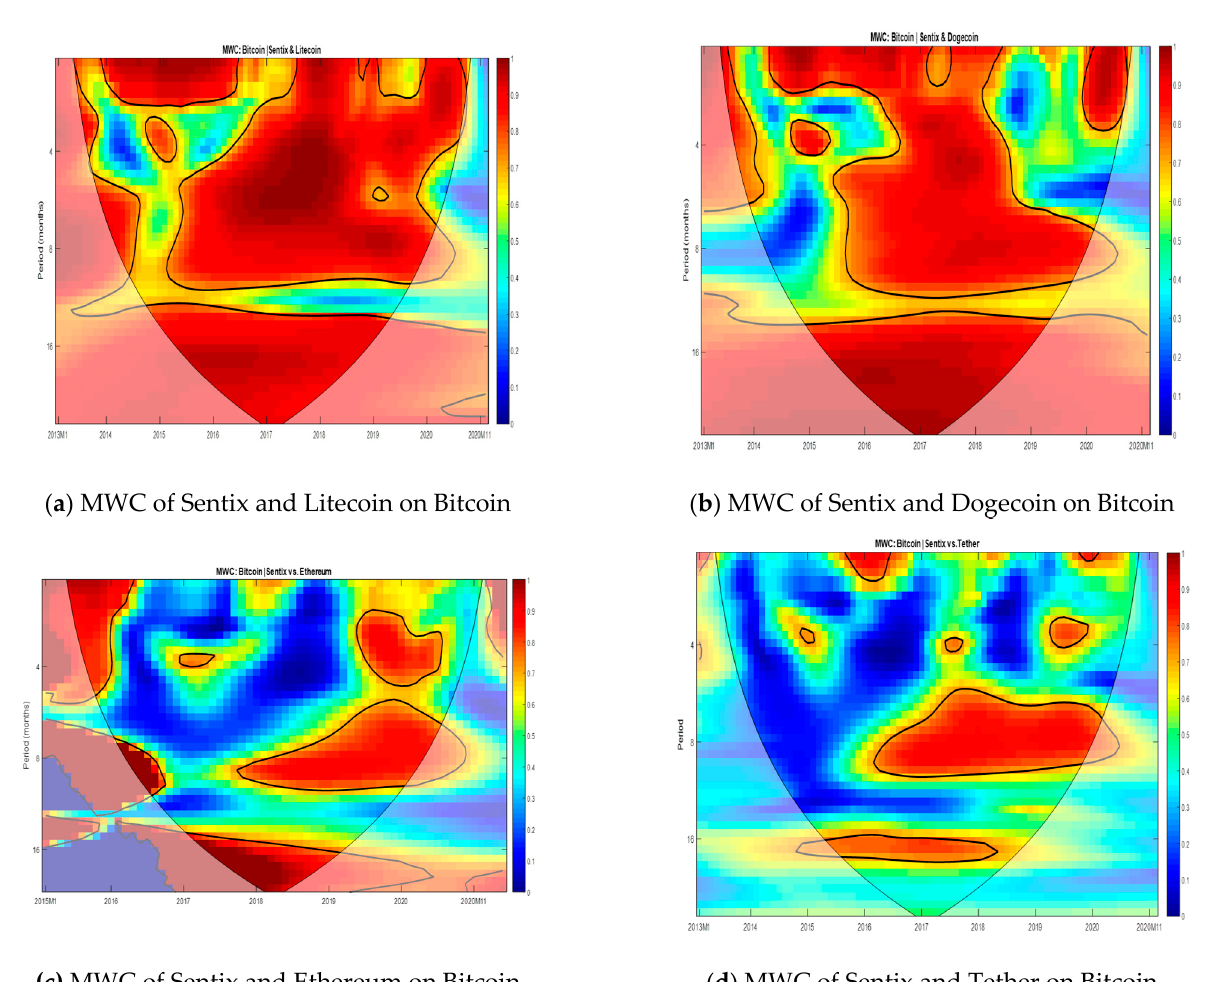
Figure 4. The multiple wavelet coherencies between Bitcoin and the Sentix Investor Confidence index and cryptocurrencies. The black contour recognizes the regions in which the spectrum is significant at the 5% level against red noise. The cone of influence (COI) is designated by the lighter shade, which delimits the high-power regions. The horizontal and vertical axes denote time and scale bands, respectively. From these plots, the combined effects of investor sentiment and CC on Bitcoin prices are revealed over different scales.